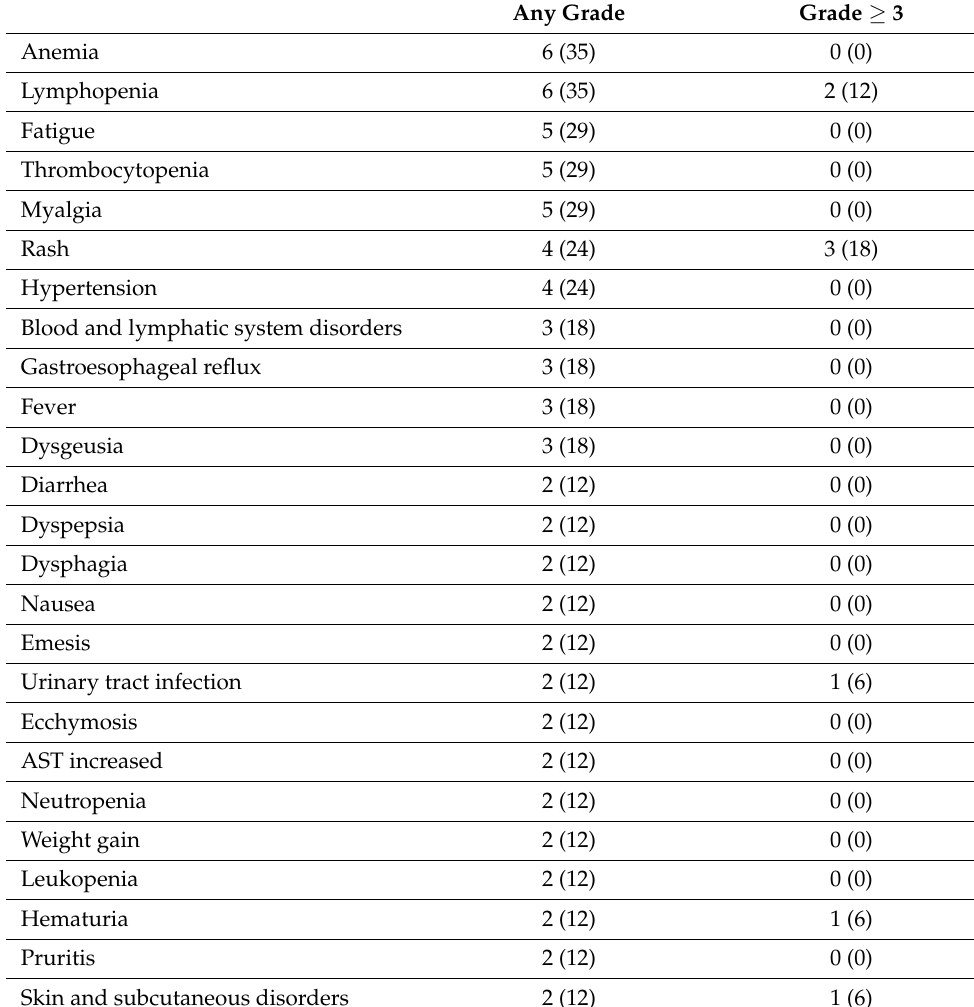
Table 3. Treatment-related Adverse Events in ≥ 10% of